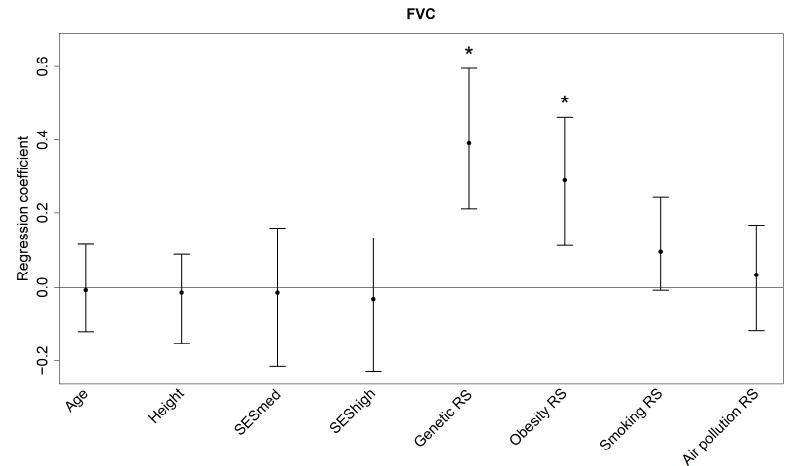
Figure 4. Regression coefficients (bootstrap median and 95% confidence interval) of the predictors for FVC. The coefficients reflect the change in the z-score for one unit increase in the single Predic- tors and one Interquartile Range Increase in the Risk Scores. FVC: forced vital capacity; RS: risk score; SESmed: medium socio-economic status (reference: low socio-economic status); SEShigh: high socio-economic status (reference: low socio-economic status); * p < 0.05.